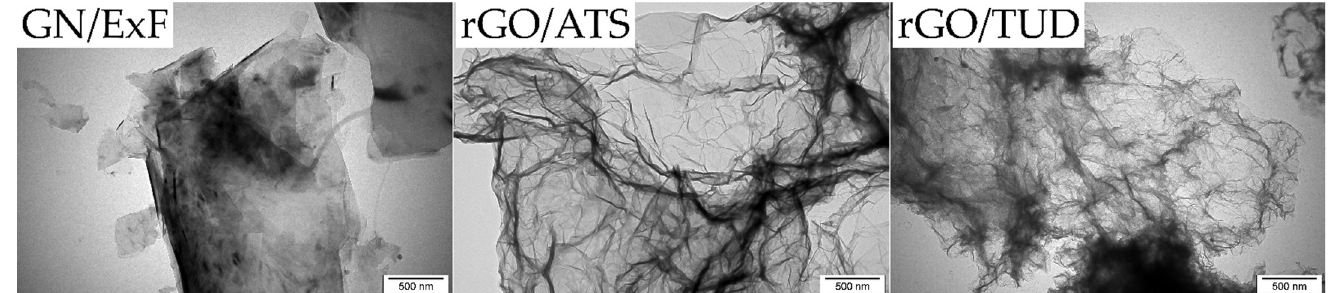
Figure A1. Transmission electron microscopy (TEM) images. Images of GN/ExF flakes and two types